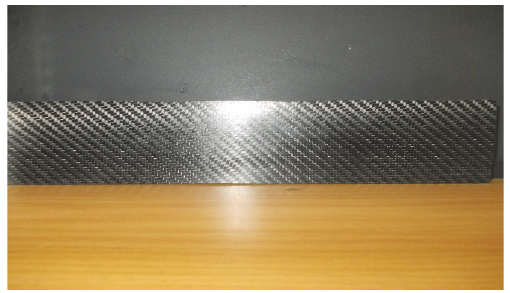
Figure 1: Defect-free composite sample.